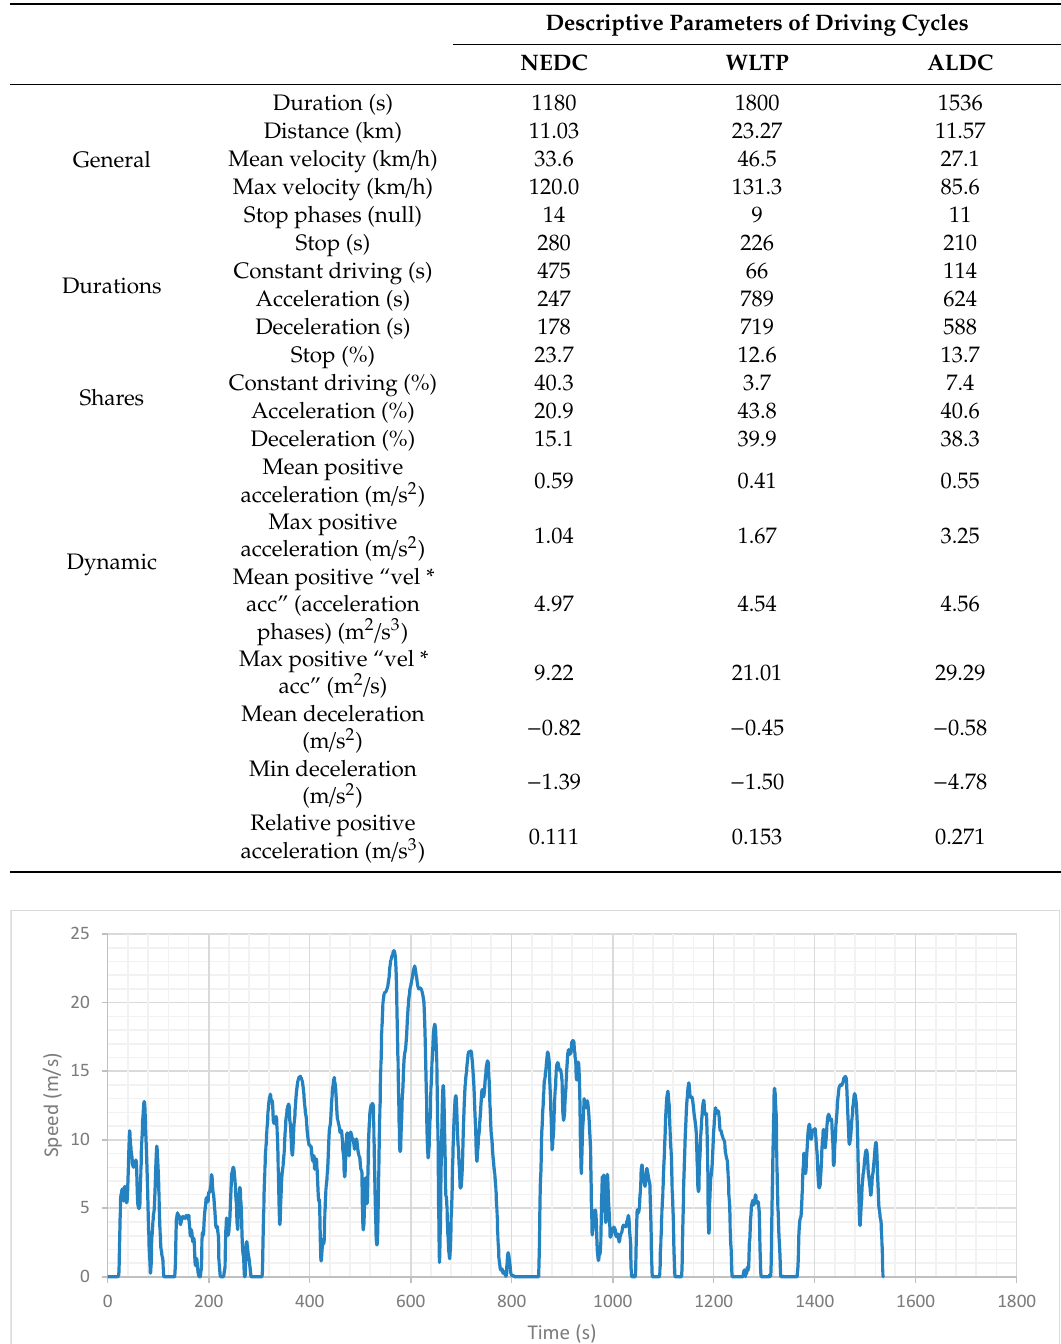
Table A2. Main descriptive parameters for the considered drive cycles.